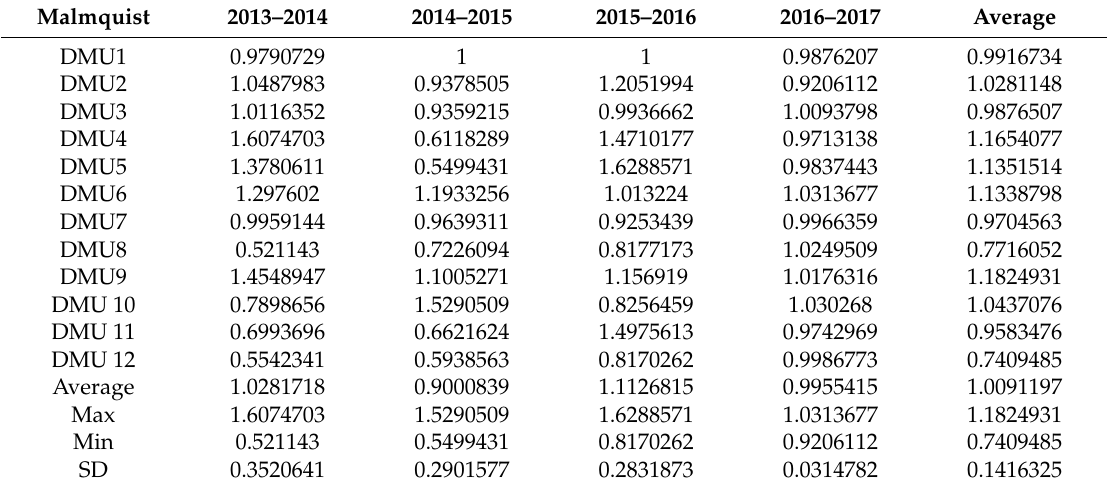
Table 9. Productivity index (Malmquist-MPI) change over the period from 2013 to 2017.